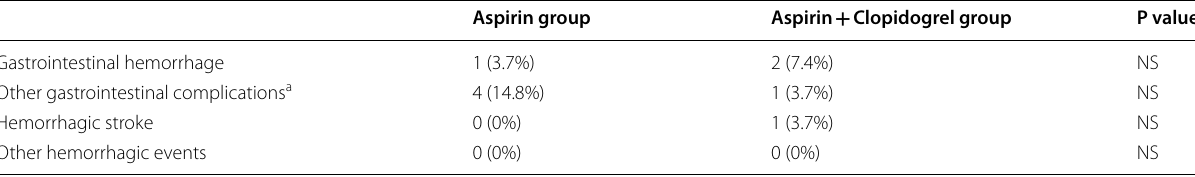
Table 4 The frequencies of adverse drug effects in each